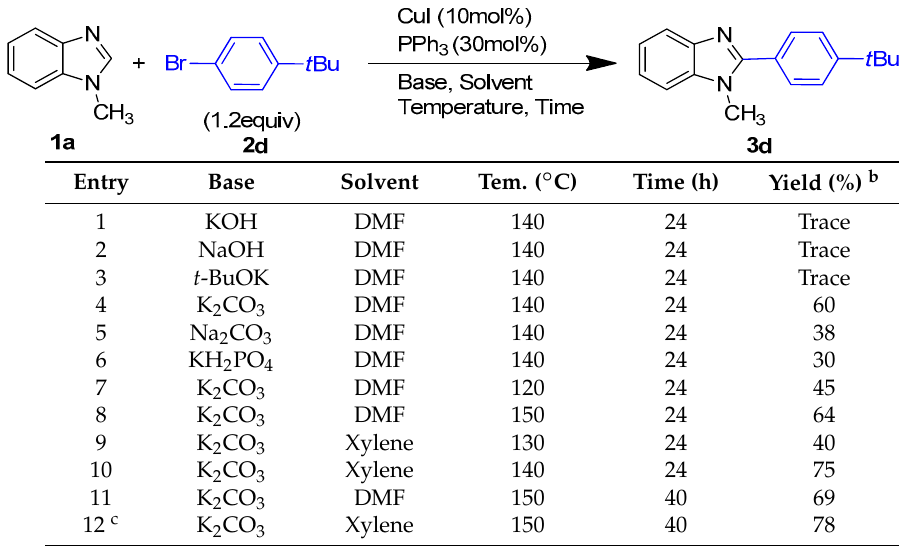
Table 1. Optimization of direct 2-arylation of 1-methyl-benzimidazole 1a with 1-bromo-4-tert-butylbenzene 2d a .